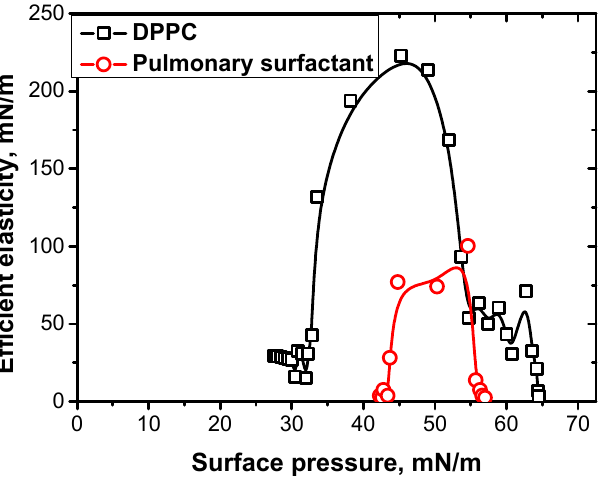
Figure 9. The dependencies of efficient surface elasticity at a frequency of 0.03 Hz and temperature of 35 °C on the surface pressure for a spread monolayer of DPPC (black squares) and adsorbed layers of pulmonary surfactant solutions at a concentration of 1.25 mg/mL (red circles). Data taken from [85,86].